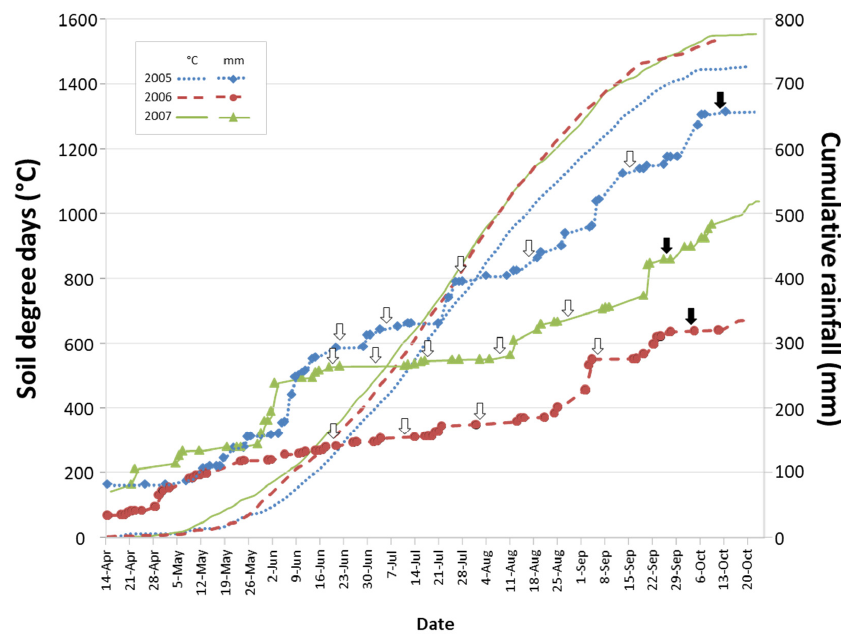
Figure 1. Soil degree days (10 °C base), cumulative precipitation, and soil mineralization incubation sampling intervals within the growing seasons of 2005 through 2007. Open arrows indicate initial bulk sampling and starting points for incubation intervals, closed arrows indicate the last sample date for core and resin retrieval. Each rainfall data point represents a single rain event.